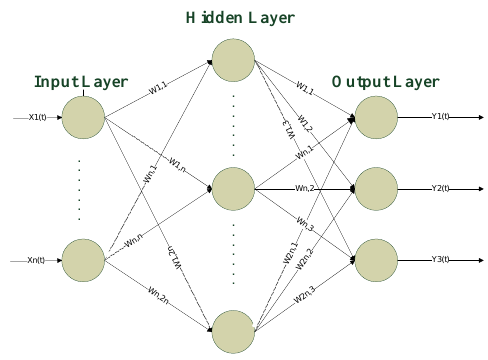
Fig. 2. The implemented Neural Network